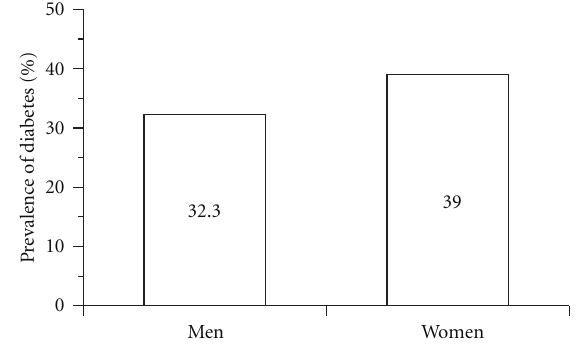
Figure 2: Prevalence of measured diabetes among men and women from two remote First Nations communities of northwestern Ontario, Canada. Diabetes was defined as fasting glucose levels ≥ to 7.0 mmol/L and/or a 2-h post glucose load level ≥ 11.1 mmol/L.